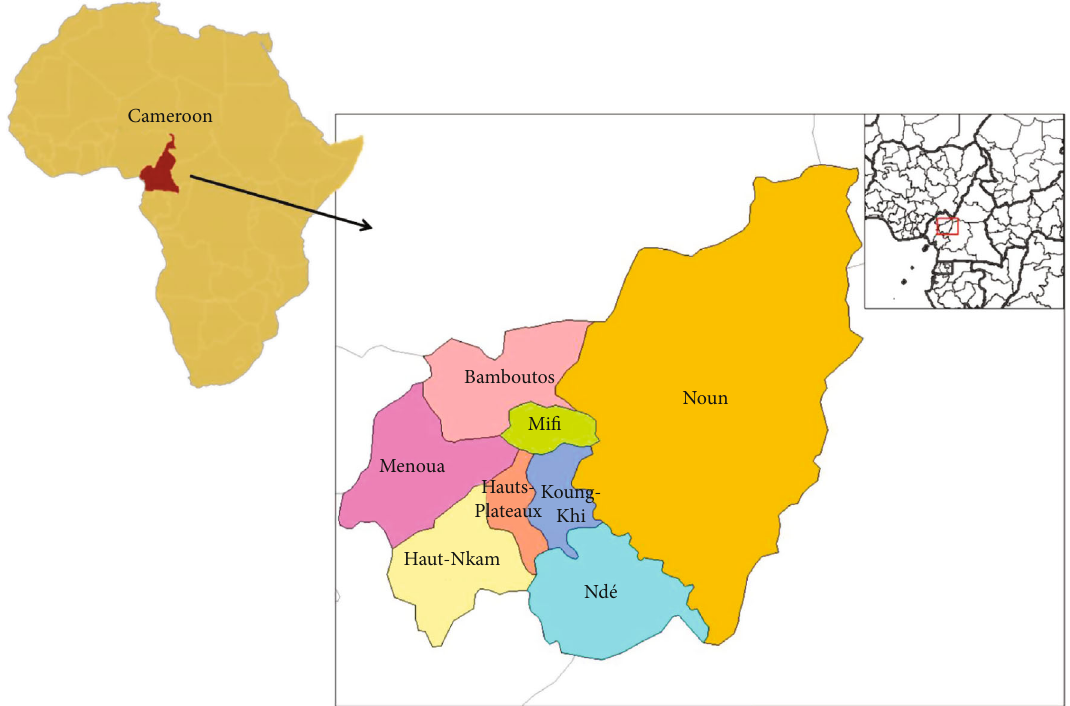
Figure 1: Map of the West region of Cameroon showing Menoua